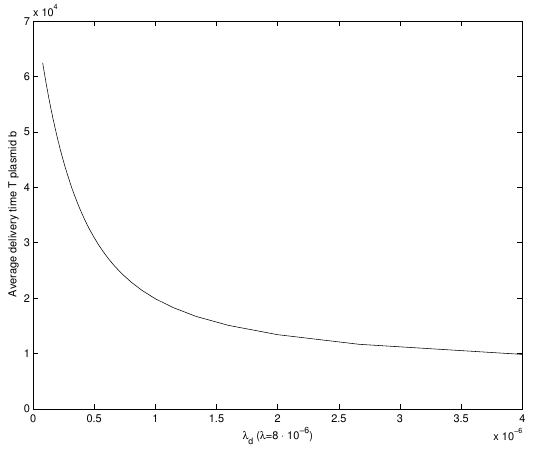
Figure 6: CDF of the delivery time T for a single plasmid dissemination with a single attractant